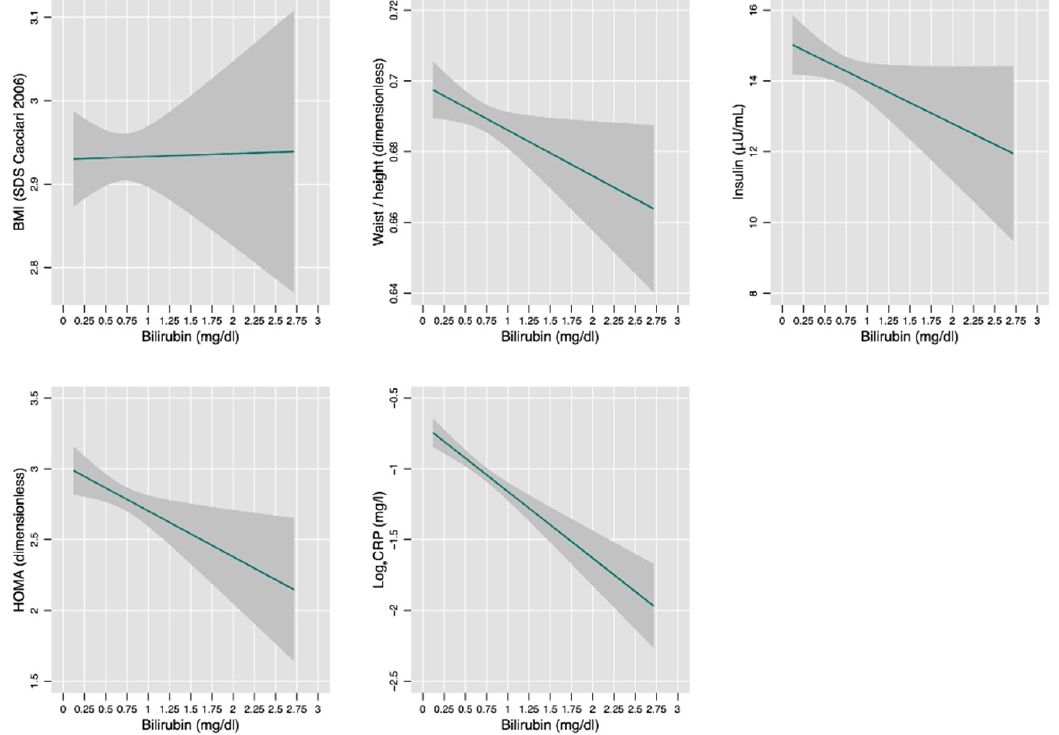
Figure 3. Association between bilirubin and anthropometric and laboratory measurements. See Table 3 for the underlying linear regression model. Table 3. Univariable linear regression models evaluating the association between serum total bilirubin and anthropomet- ric and laboratory measurements. Abbreviations as in Table 1. BMI